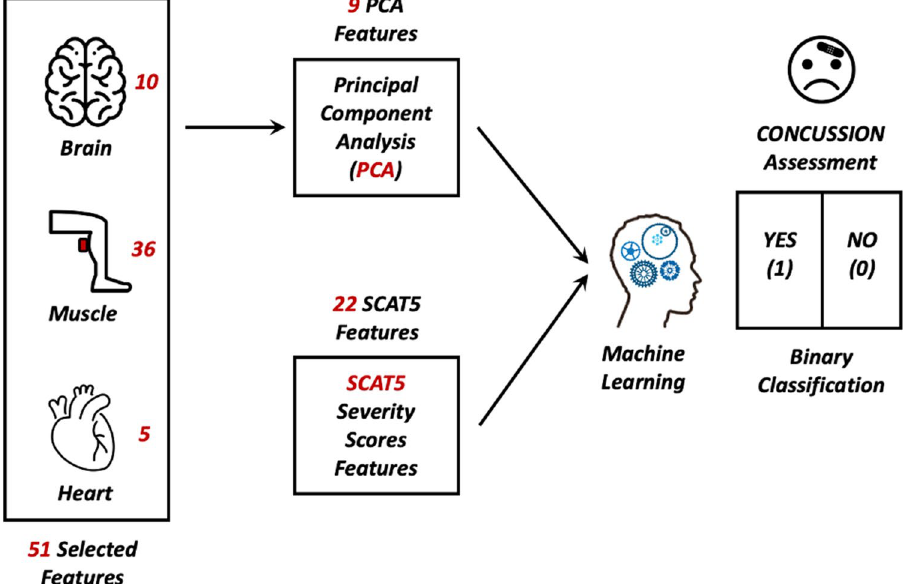
Figure 10. Feature Selection and Machine Learning Workflow. 51 features are selected from Brain, Muscles and Heart signal and on them, the PCA is performed to obtain 9 PCA features used to the binary classification of the concussion assessment using different ML algorithms; 22 SCAT5 features are then used as well as features for the concussion classification; the 22 SCAT5 and 9 PCA are then combined and used together to classify concussed and non-concussed subjects.